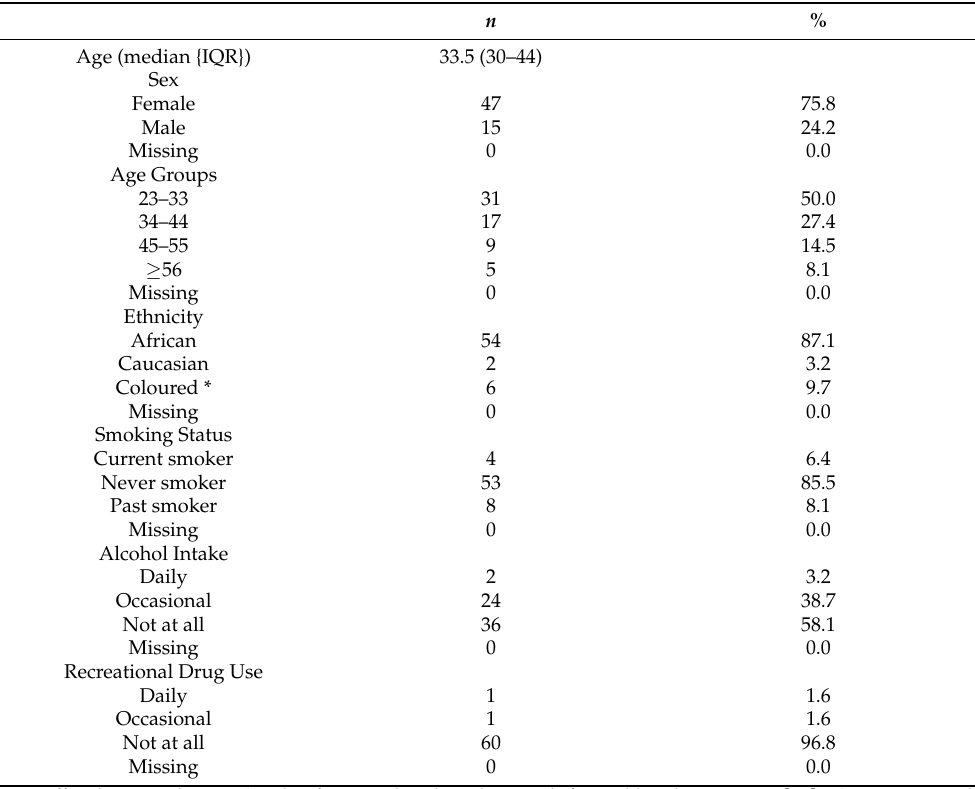
Table 1. Characteristics of survey respondents, n = 62.